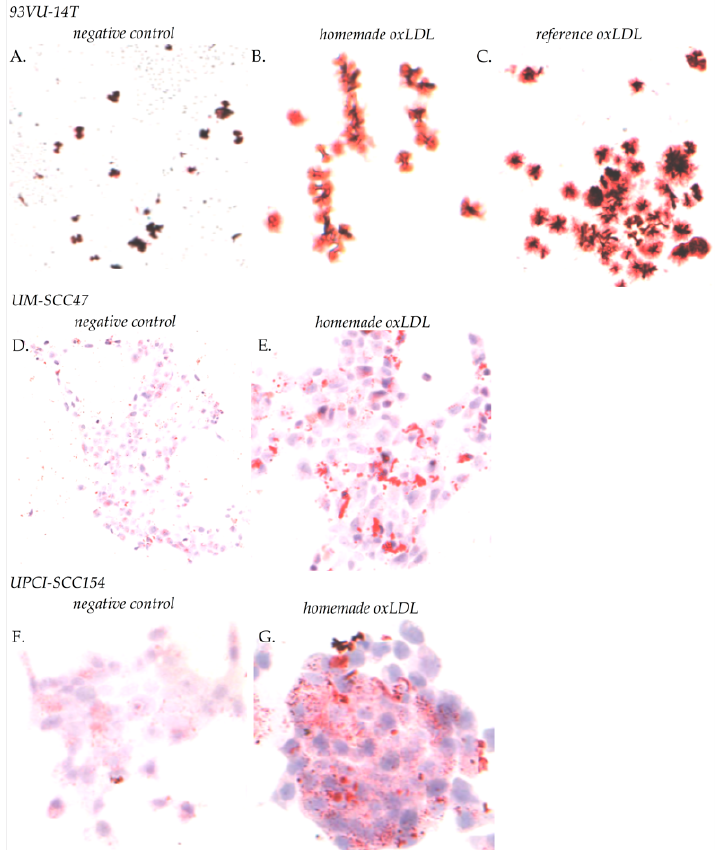
Figure 2. ( A ) Oil red O staining of HNCC cells, after 48 h of treatment (×40 magnification). 93VU- 147T cells without exposure to oxLDL (negative control); ( B ) with exposure to 30 µg/mL home-made oxLDL; or ( C ) to 30 µg/mL reference oxLDL. ( D ) UM-SCC47 cells without exposure to oxLDL; and ( E ) with exposure to 30 µg/mL home-made oxLDL. ( F ) UPCI-SCC154 cells without exposure to ox- LDL; and ( G ) with exposure to 30 µg/mL home-made oxLDL. On UM-SCC47 and UPCI-SCC154 cells, home-made oxLDL induced an uptake of 46.3% (negative control, 12.3%) (48 h exposure; Figure 2D,E) and 64.8% (negative control, 10.3%), respectively (48 h exposure; Figure 2F,G) (UM-SCC47 home-made oxLDL vs. nega- tive control, t -test, p = 0.006; UPCI-SCC154 home-made oxLDL vs. negative control, t -test, p = 0.002). 2.3. Scavenger Receptors Expression on HNCC upon Exposure to oxLDL Exposure of HNCC to oxLDL for 48 h results in a significant increase in both CD36 and LOX-1 expression, equally in the three tested cell lines (Figures 3 and 4). The mean fluorescence intensity (MFI), corresponding to the CD36 expression in 93VU-147T cells in negative control conditions (no treatment), was 15.54, compared with 24.29 for home- made oxLDL and 24.00 for reference oxLDL (Figure 3A–C,H; t -test, p = 0.028 and p = 0.005, respectively against negative control). The LOX-1 MFI in the 93VU-147T cells negative control (no treatment) was 14.97 compared with 24.39 for home-made oxLDL and 24.85 for reference oxLDL (Figure 4A–C,H; t -test, p = 0.026 and p = 0.017, respectively). No